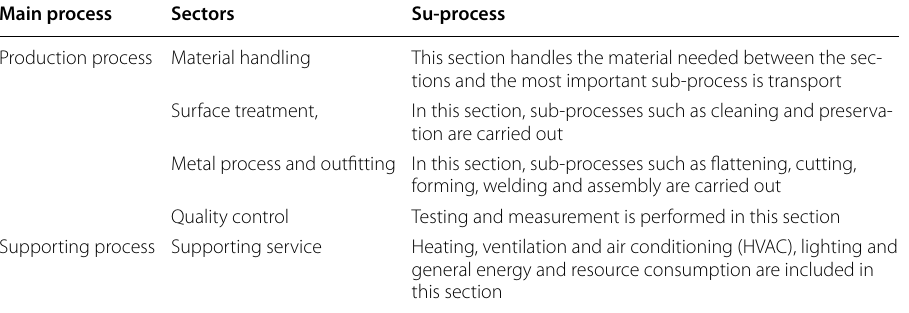
Table 1 Ships’ breakdown production (Wahidi et al. 2021)